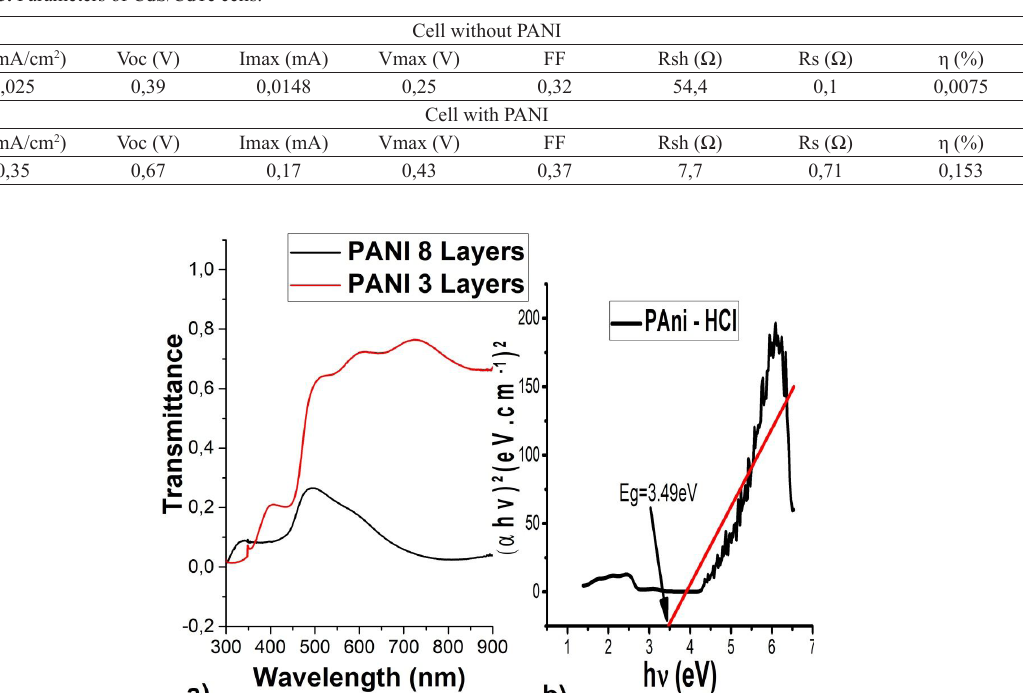
Table 5. Parameters of CdS/CdTe cells.